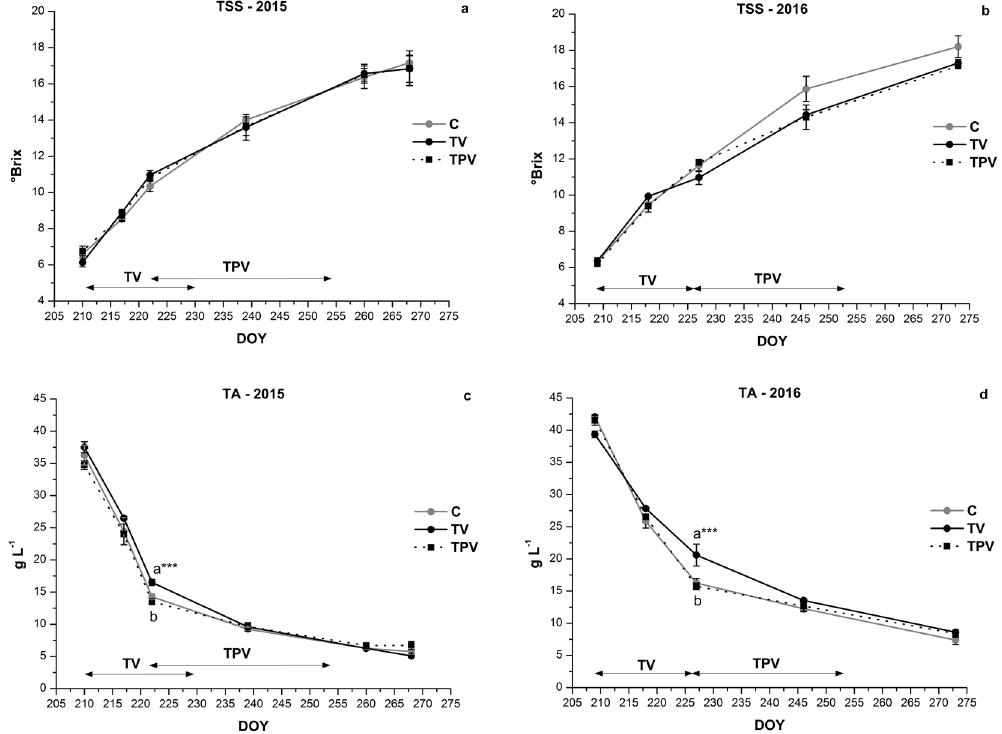
Figure 3. Evolution of total soluble solid content (TSS; a , b ) and titratable acidity (TA; c , d ) for Corvina vines treated at low temperature in the night and for the control during the ripening, in 2015 and 2016. Error bars indicate the mean SE ( n = 3). Means followed by different letters differ significantly, as calculated by Tukey statistical analysis ( * , ** , *** p ≤ 0.05, 0.01, 0.001, respectively). The duration of the low night temperature periods is indicated by black double arrows, for TV and TPV treatments.